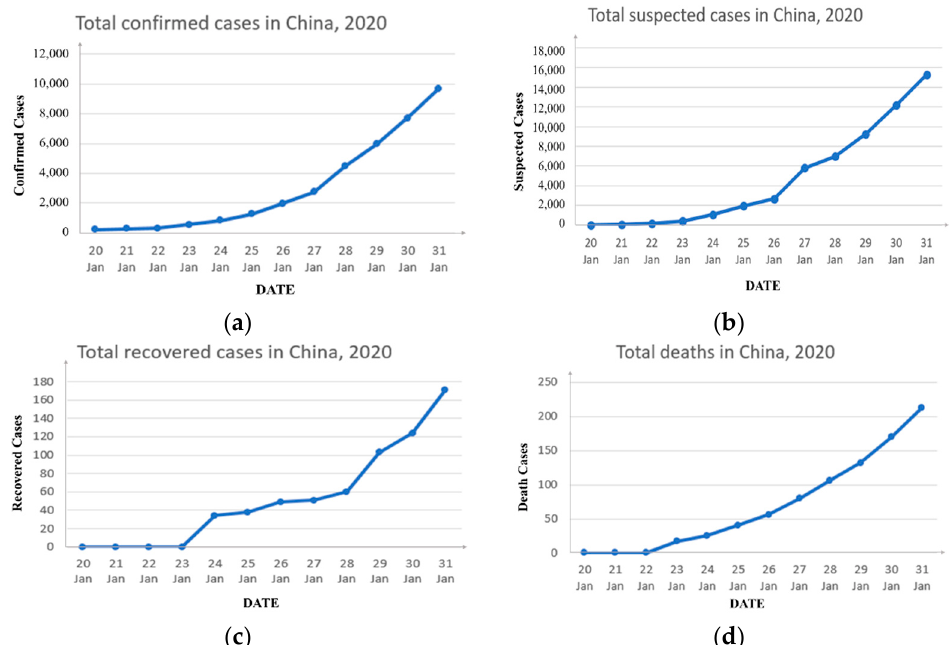
Figure 1. Official statistics. ( a ) The number of confirmed cases due to COVID-19 from 20 January to 31 January; ( b ) the number of suspected cases due to COVID-19 from 20 January to 31 January; ( c ) the number of recovered cases due to COVID-19 from 20 January to 31 January; ( d ) the number of deaths due to COVID-19 from 20 January to 31 January.